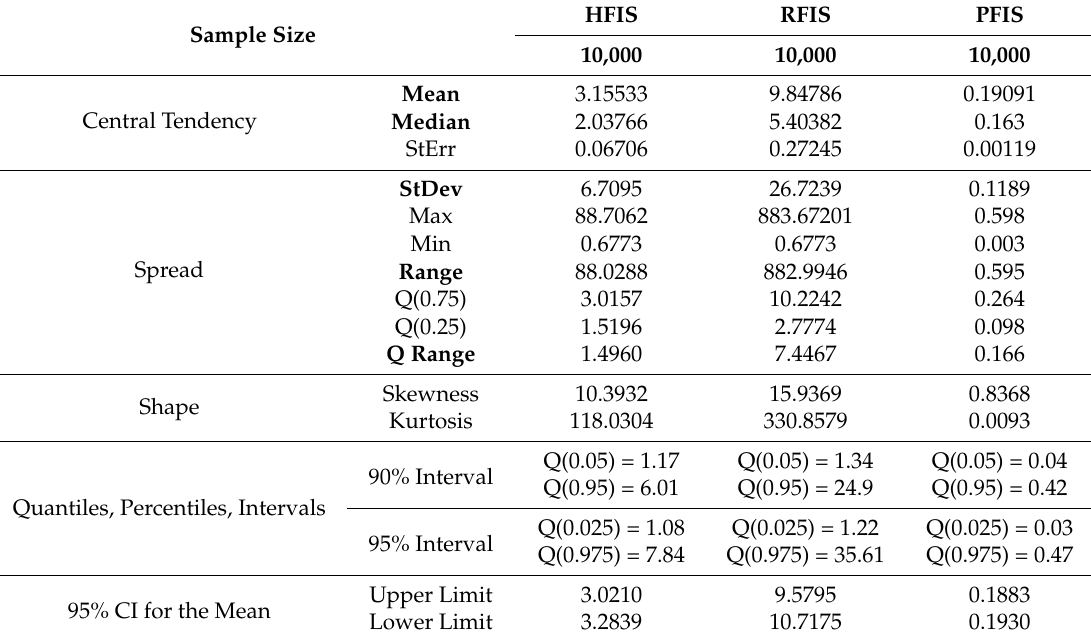
Table 4. Summary statistics of stochastic